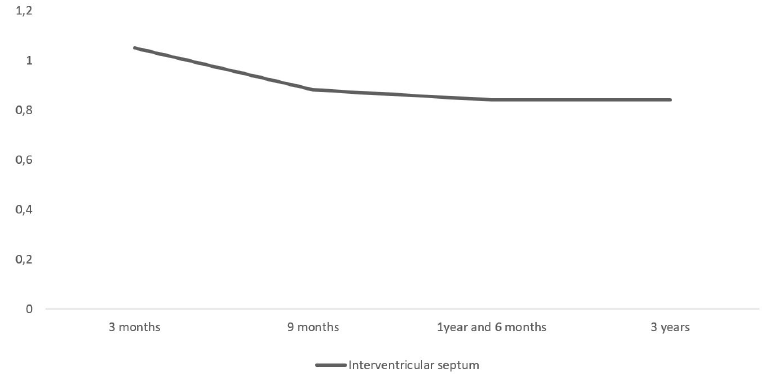
Figure 7. Graph representing of the variation of the thickness of the interventricular septum in relation to the age of the patient after balloon